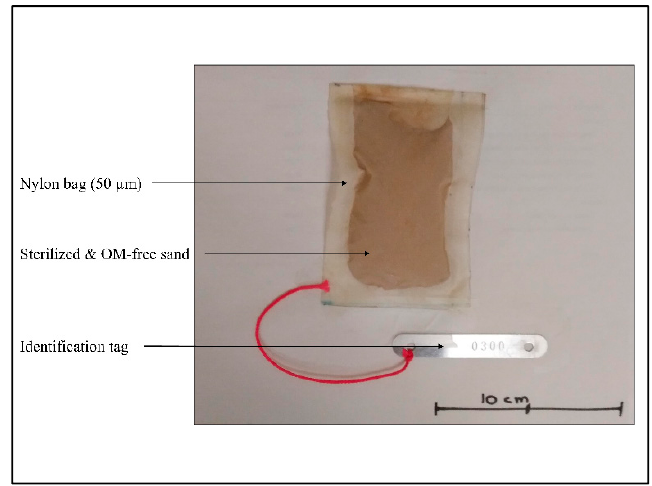
Figure 1. An example of a nylon sand bag. The bag (50 µm pores) is filled with sterilized and organic matter (OM)-free sand.